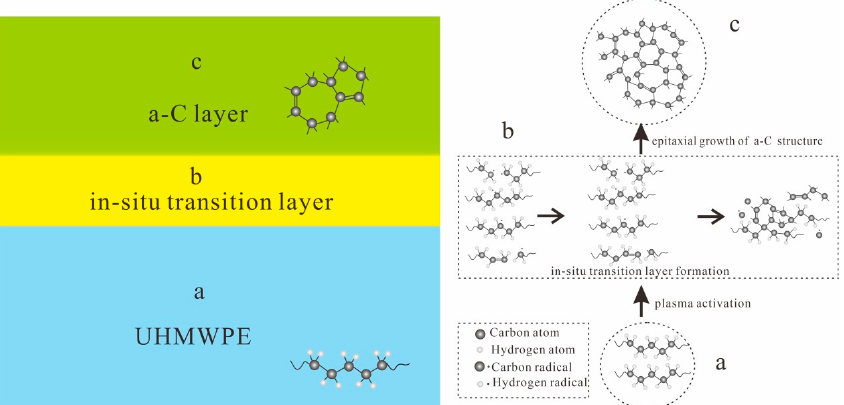
Figure 6. Growth mechanism of a-C film on UHMWPE substrate: ( a ) plasma activation, ( b ) in-situ transition layer formation, ( c ) epitaxial growth of amorphous carbon structure.